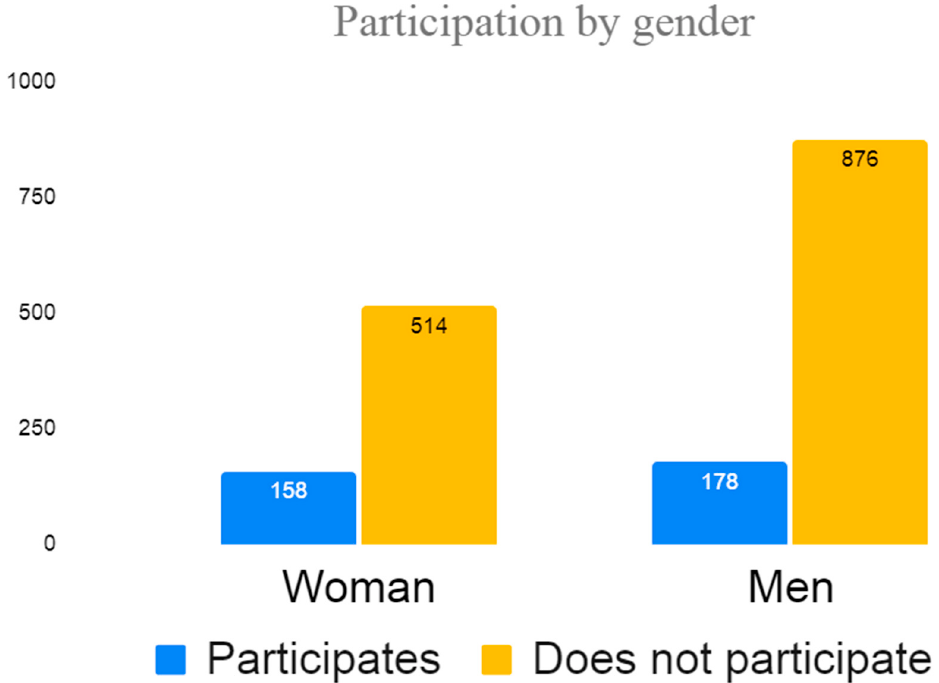
Figure 1. Participation distribution by gender.